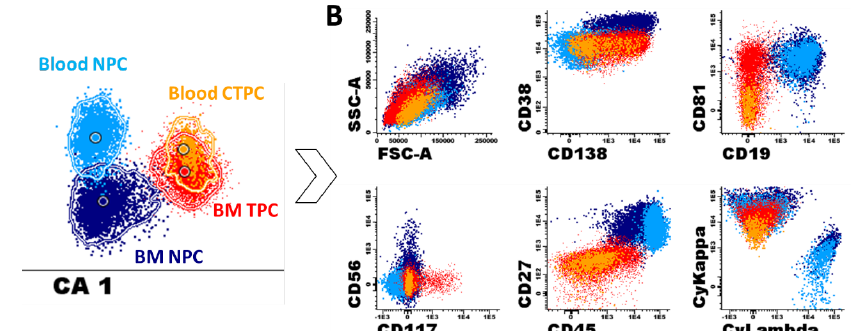
Figure 3. Example of the immunophenotypic differences observed by NGF between normal and tumor PC from paired BM and blood samples from a representative MM patient studied after HDT followed by ASCT. Multivariate canonical analysis (CA) plot ( A ) and classical two-dimensional dot plot representations ( B ) show the immunophenotypic differences between BM TPC (red dots) and PB CTPC (orange dots), and between normal PC from BM (dark blue color) and PB (light blue dots) following the EuroFlow NGF-MM minimal residual disease (MRD) approach. ASCT, autologous stem cell transplantation; BM, bone marrow; CTPC, circulating tumor plasma cells; HDT, high-dose therapy; MM, multiple myeloma; NPC, normal plasma cells; PB, peripheral blood; PC, plasma cells; TPC, tumor PC. Data modified from Sanoja-Flores et al. [35].